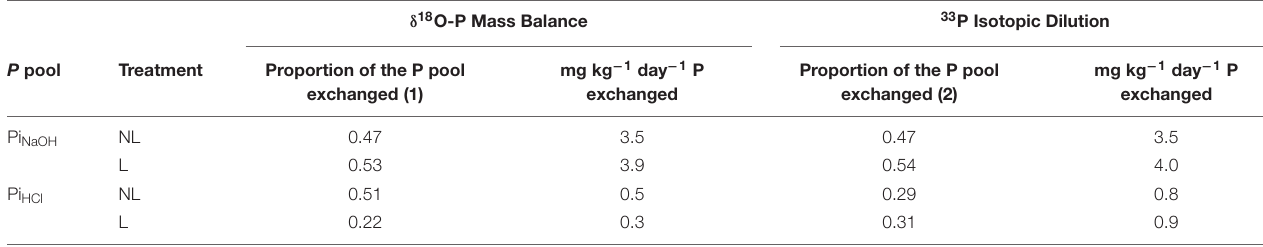
TABLE 3 | Estimation of P exchange fluxes in the Bad Brückenau (BBR) soil between the available and other inorganic P pools over 93 days according to a mass balance ( δ 18 O-P data from this study) or to an isotopic dilution approach ( 33 P data from Pistocchi et al.,